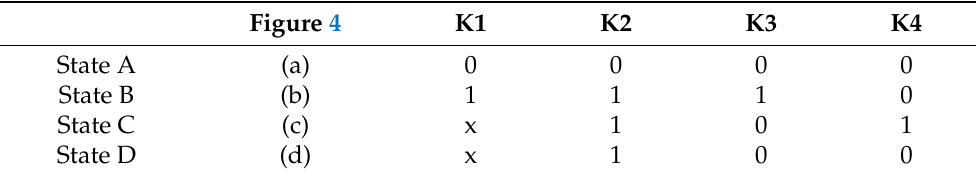
Figure 4. Safe states for the switching box. ( a ) State A, panel in the main circuit; ( b ) State B, panel in the testing circuit; ( c ) State C, short-circuited panel; ( d ) State D, panel with open connection. Table 1. Control vector for reachable safe